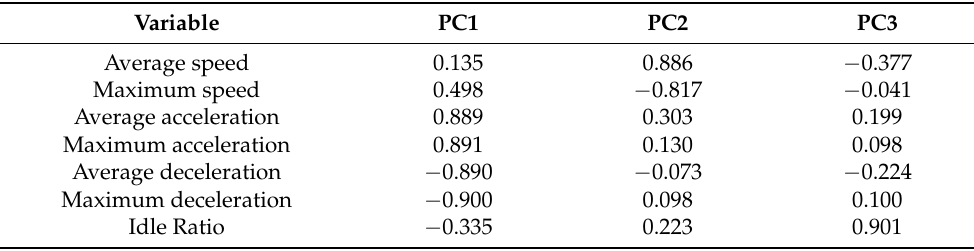
Table 10. PC score of each PC